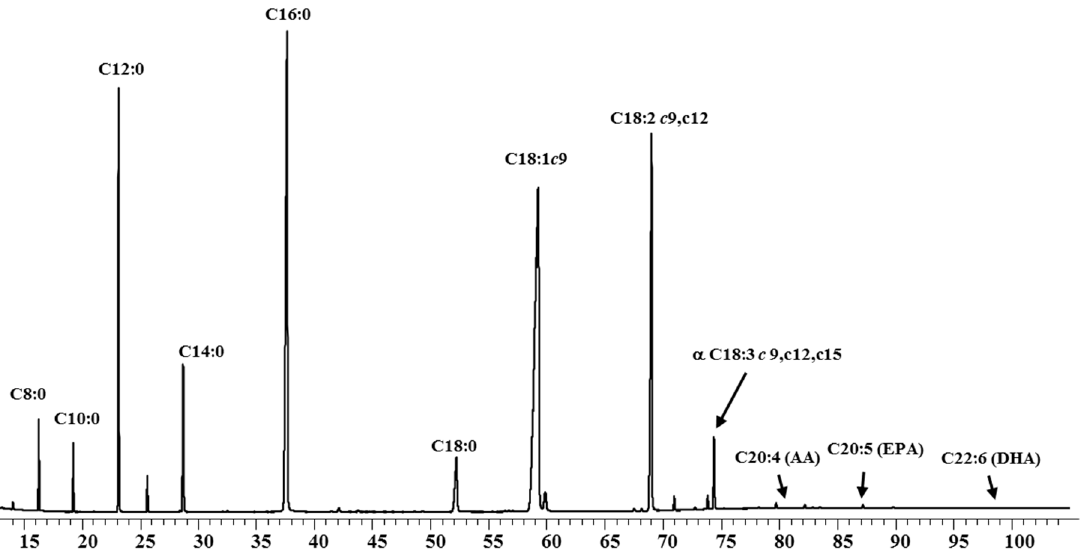
Figure 1. Fatty acid profile of infant formula (IF2) by gas chromatographic. c: cis ; t: trans ; AA: arachidonic acid; EPA: eicosapentanoic fatty acid; DHA: docosahexanoic fatty acid.